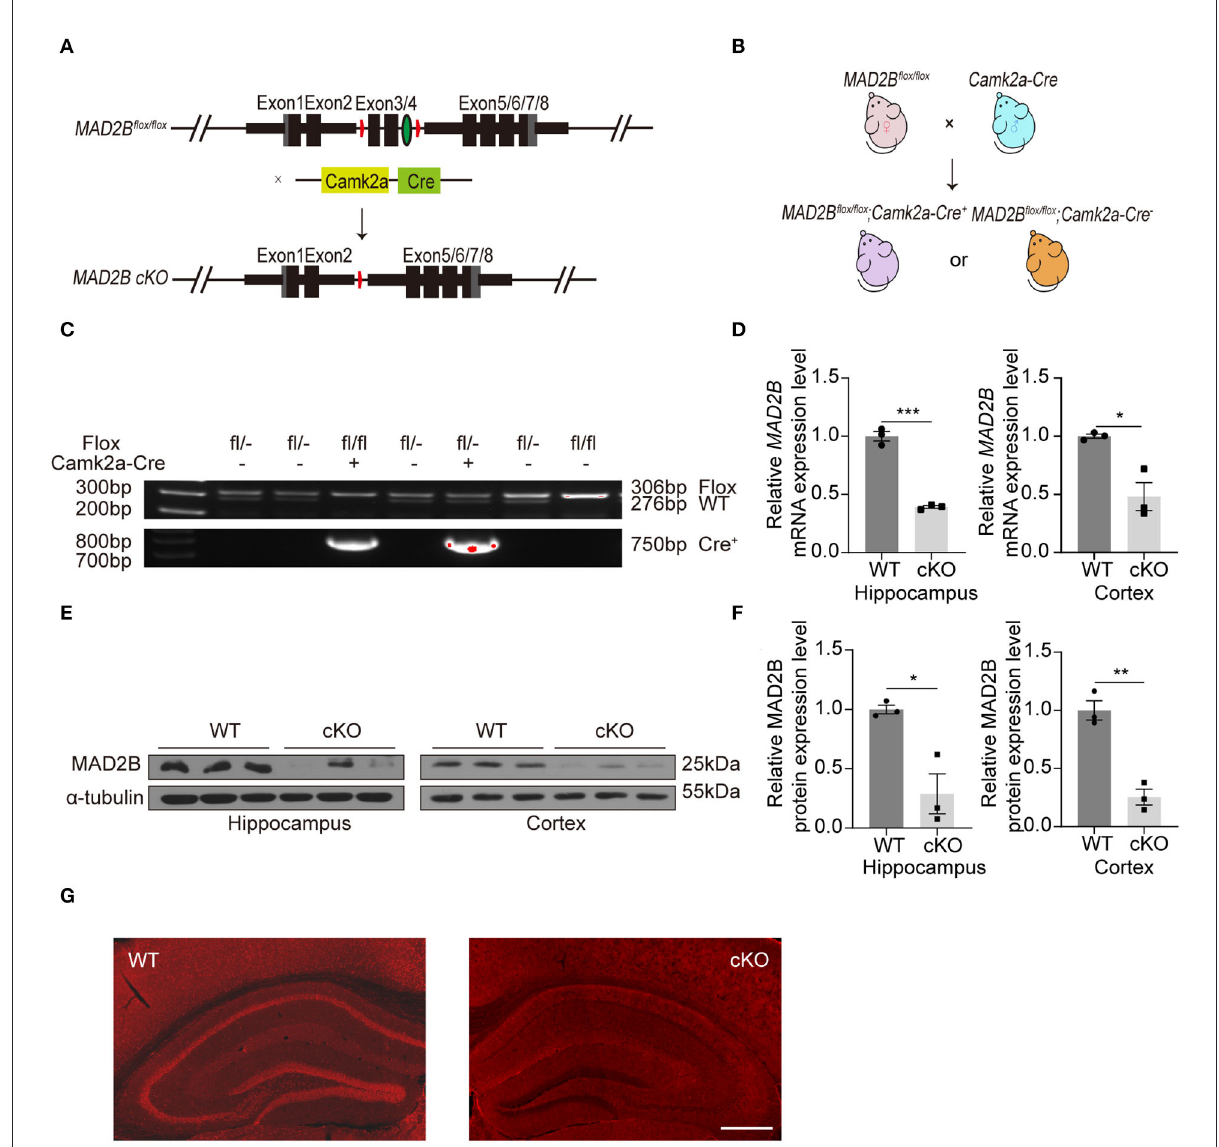
FIGURE1 The generation and identification of the MAD2B cKO mice. (A) Schematic diagram of MAD2B cKO by the Cre/loxP system. (B) Schematic representation of the breeding strategy. (C) Tail DNA PCR confirmation of transgenic MAD2B cKO mice. (D) qRT-PCR validation of the downregulation of the MAD2B gene in the hippocampus ( p = 0.0001, t = 14.310, unpaired two-tailed t- test) and cerebral cortex ( p = 0.0467, t = 4.272, unpaired two-tailed t- test with Welch’s correction), n = 3. (E,F) Western blot analysis showing the downregulation of MAD2B protein expression in the hippocampus ( p = 0.0459, t = 4.136) and cerebral cortex ( p = 0.0023, t = 6.943), n = 3. Unpaired two-tailed t- test. (G) Representative immunofluorescence images validating the cKO of MAD2B in the hippocampus and the cerebral cortex including MPtA, LPtA, PtPD, PtPR, and S1BF, the scale bar is 500 µ m. * p < 0.05, ** p < 0.01, *** p < 0.001. All data are displayed as means ±